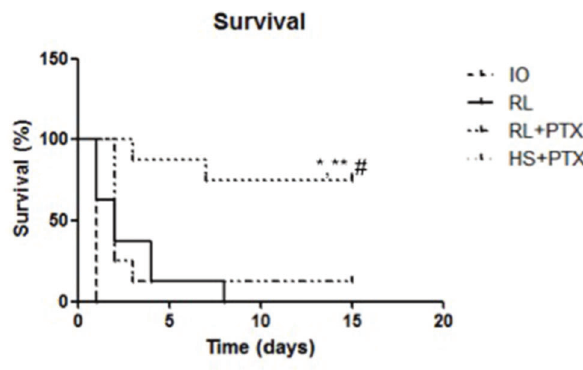
Figure 4 - Kaplan-Meier survival analysis of animals. Wistar rats were assigned to four groups: no resuscitation (IO-intestinal obstruction and ischemia), Ringer ’ s lactate (RL), Ringer ’ s lactate + pentoxifylline (RL + PTX), and hypertonic saline + pentoxifylline (HS + PTX). Rats were observed for 15 days. ( p o 0.05) * versus IO; ** versus RL; # versus RL +